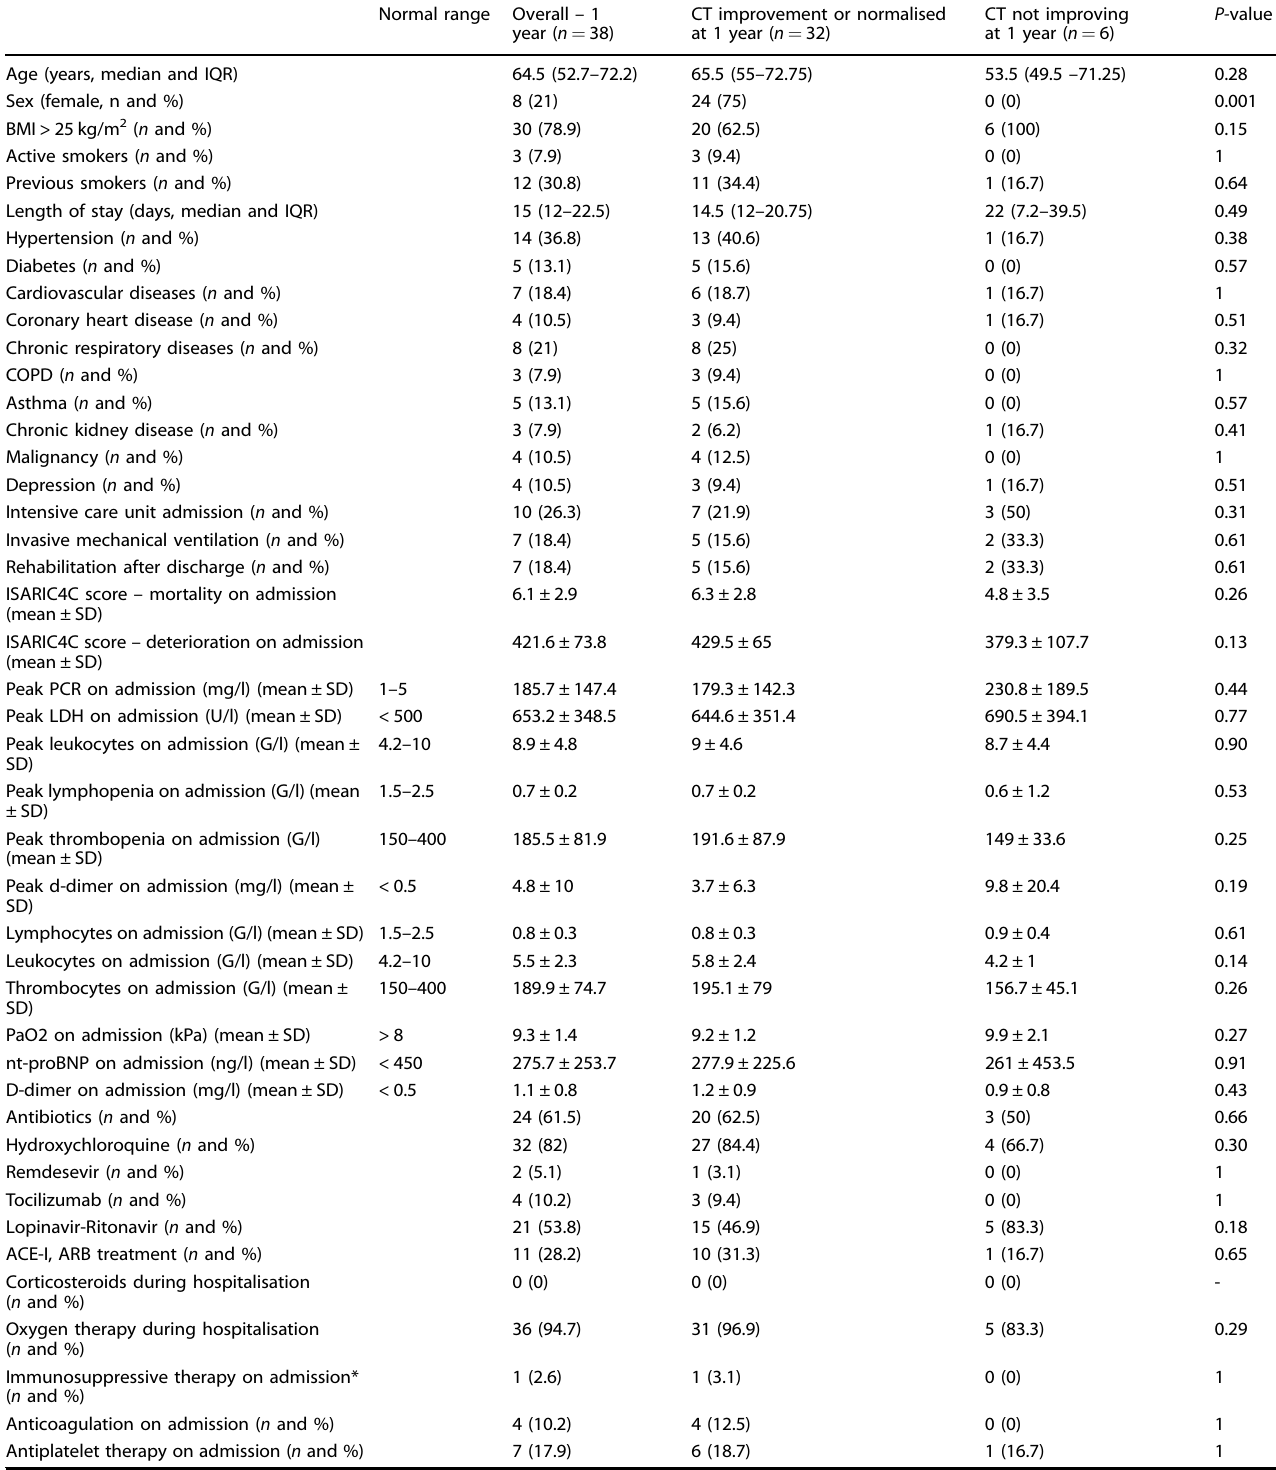
Table 1. Clinical characteristics of included patients.